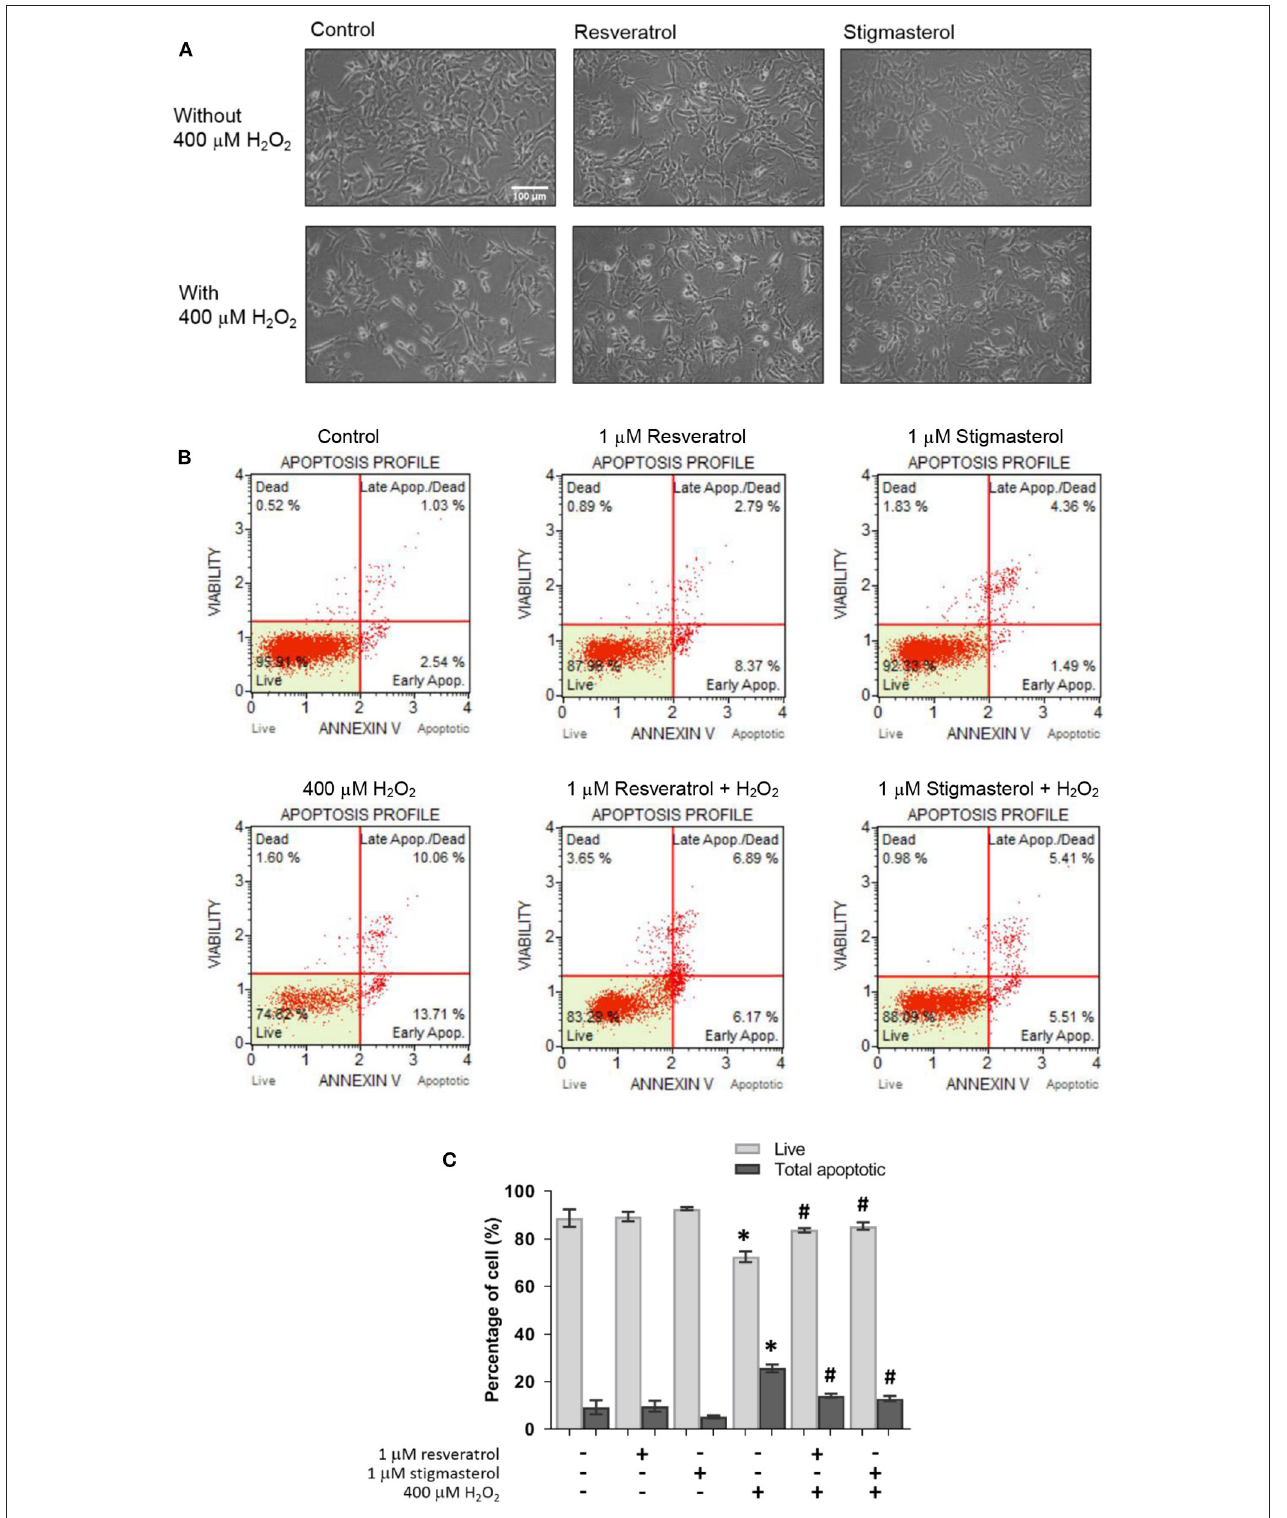
FIGURE 3 | Resveratrol and stigmasterol inhibited apoptosis caused by H 2 O 2 . (A) Morphology of SH-SY5Y cells was observed under the inverted-light microscope at 20 × magnification, scale bar 100 µ m. (B) Representative plots of live and apoptotic cells as measured by flow cytometry on pretreatment of 1 µ M resveratrol and stigmasterol exposed to 400 µ M H 2 O 2 for 24h. (C) Bar chart of live and total apoptotic cells. Data are presented as mean ± S.E.M. of three independent experiments (* p < 0.05 vs. control; # p < 0.05 vs. H 2 O 2 -treated group).